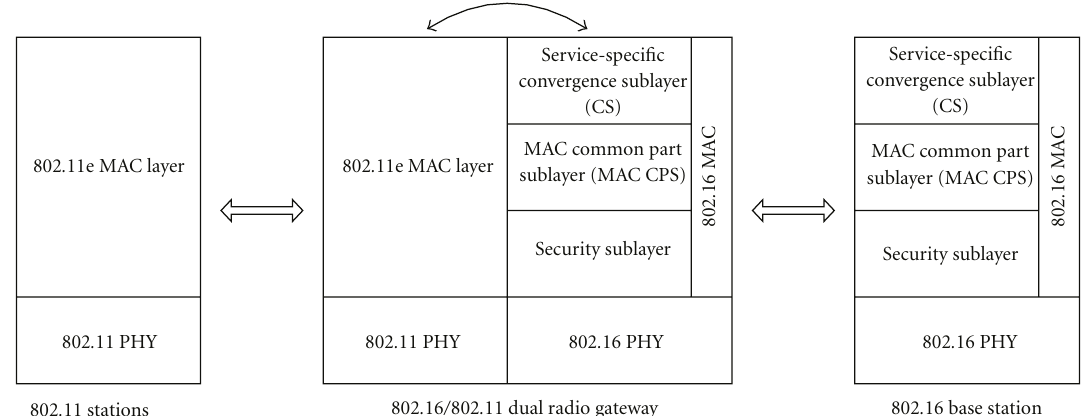
Figure 4: The protocol stack for the interworking of IEEE 802.11 and IEEE